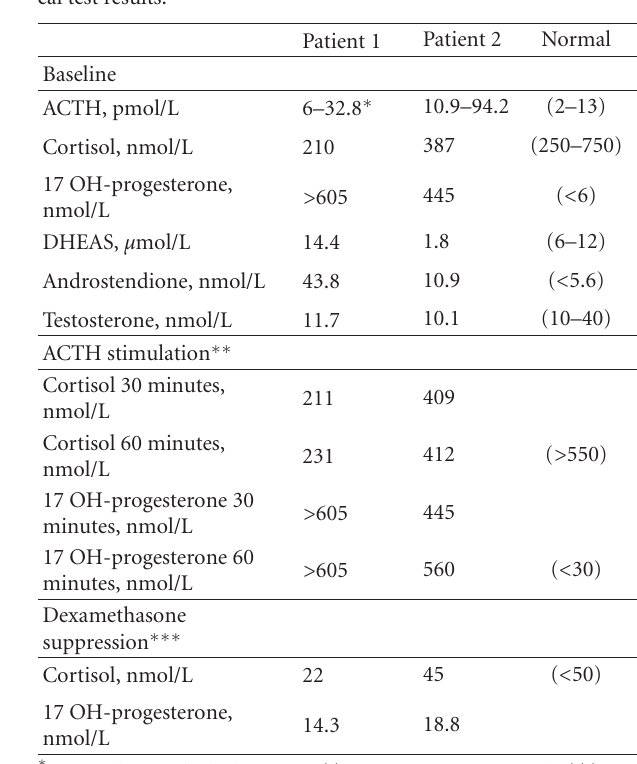
Table 1: Myelolipoma: baseline measurements and endocrinologi- cal test